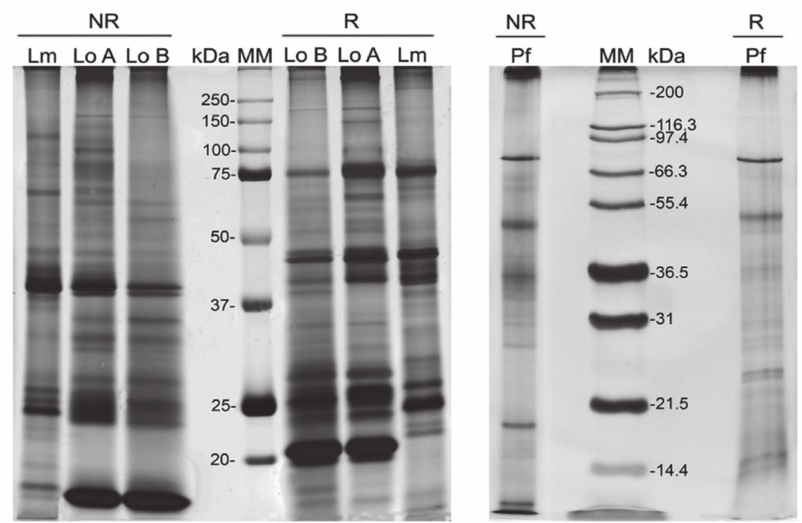
Figure 7. One-dimensional electrophoretic profile of ( A ) Saturniidae and ( B ) Megalopygidae venom extract under reducing (R) and non-reducing (NR) conditions. Lo A: Lonomia obliqua from Argentina; Lo B: Lonomia obliqua from Brazil; Lm: Leucanella memusae ; Pf: Podalia ca. fuscescens ; MM: molecular mass markers. The figure was copied from Quintana et al. (2017) [18] with permission from